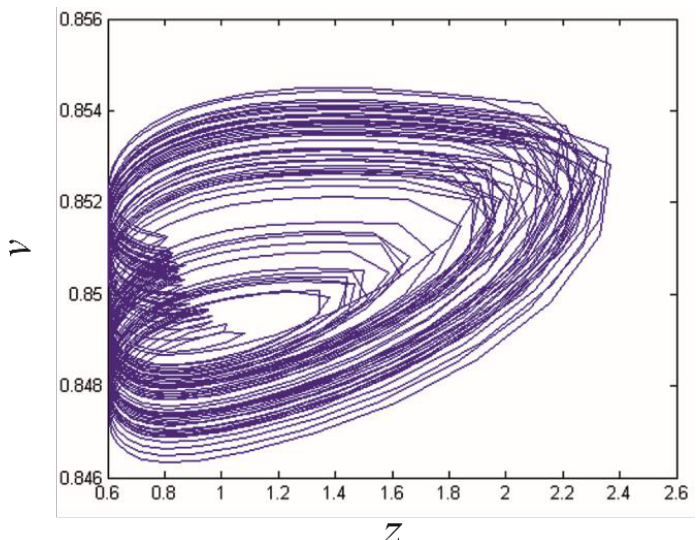
Figure 6. Bidimensional attractor ( z , v ) with open cycle obtained for low flux in Györgyi–Field system: α = 6000/9; β = 8/23; A = 0.1 mol; C = 8.33 × 10 −4 mol; M = 0.25 mol; H = 0.26 mol and k f = 3.9 × 10 −4 .